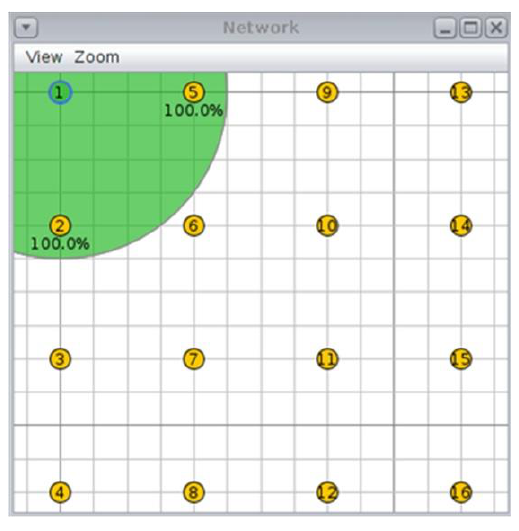
Figure 6. The physical topology. Table 1. The configuration’s main parameters.